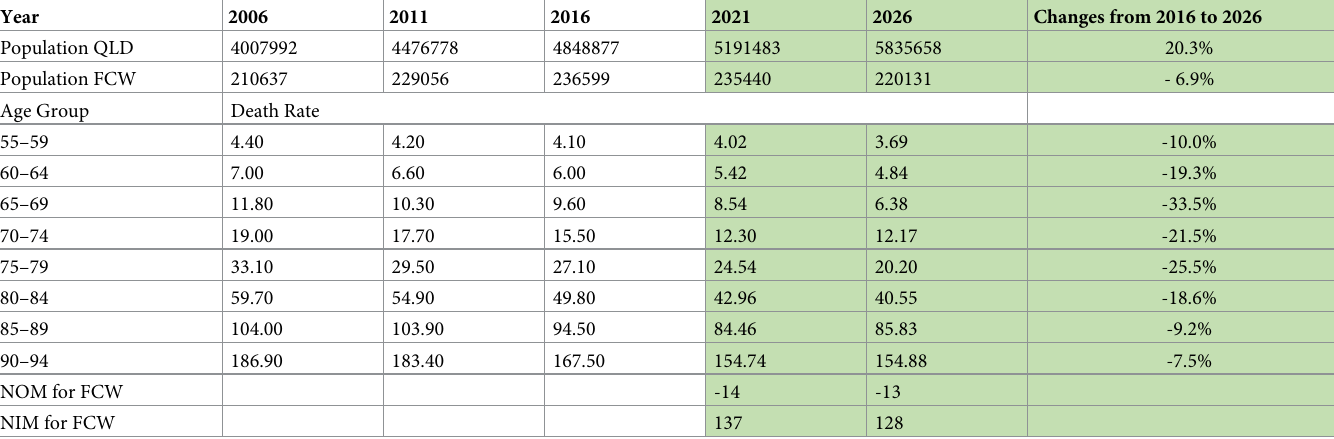
Table 6. Death rate–Qld (Green boxes indicate the estimated results).